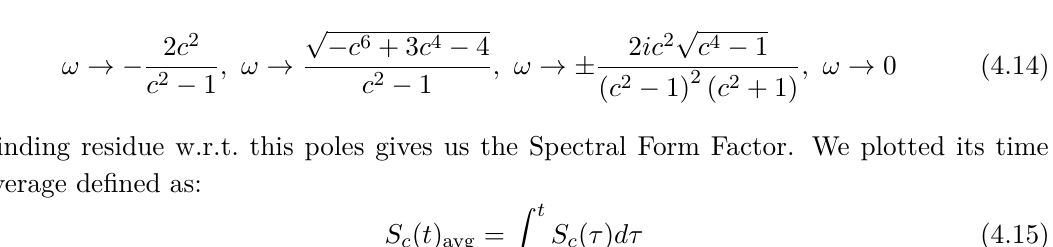
Fourier transforming the correlation function generates the spectral form